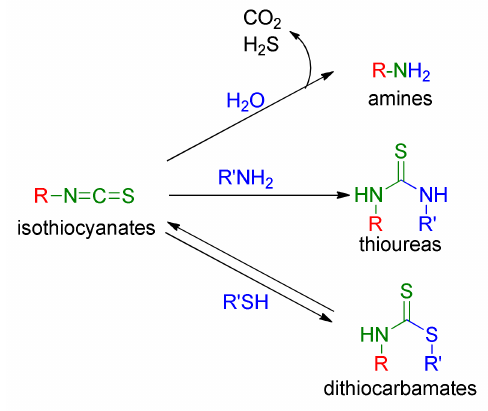
Figure 3. Reactions of isothiocyanates.